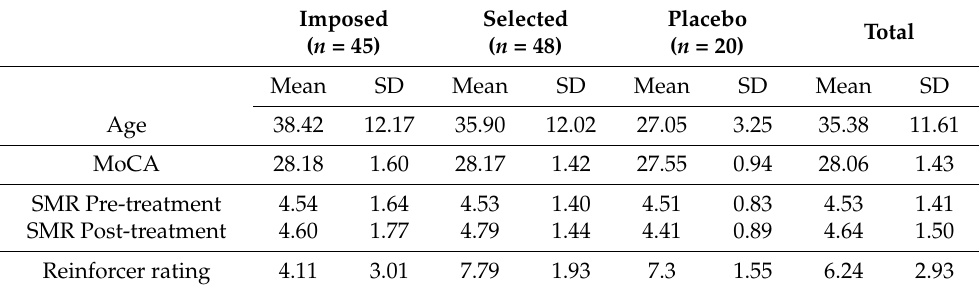
Table 2. MoCA and Neurofeeback